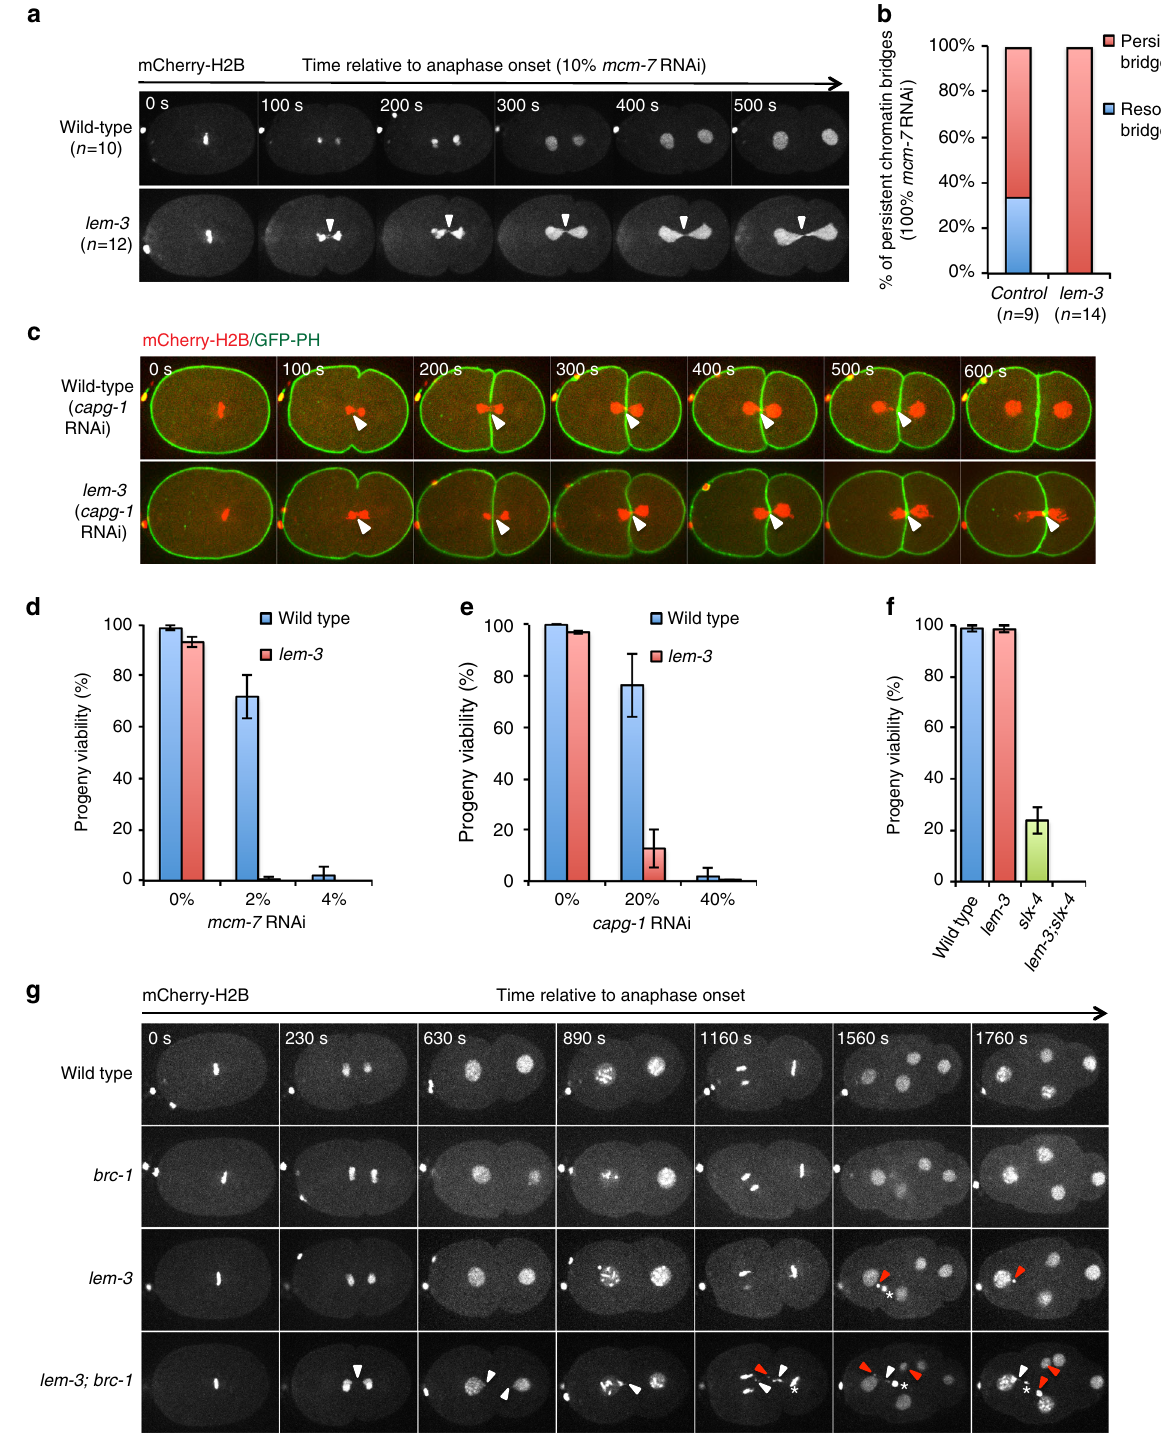
Fig. 3 LEM-3 contributes to chromatin-bridge resolution. a Chromosome segregation in wild type and lem-3 mutant embryos upon partial depletion of DNA replication helicase subunit MCM-7. Images were taken from embryos expressing mCherry-H2B fed on 10% mcm-7 RNAi producing bacteria. Arrowheads indicate chromatin bridges. Times are relative to anaphase onset of the fi rst division. b Quanti fi cation of chromatin bridges that persist into the next cell division in wild type and lem-3 mutant embryos upon full depletion of MCM-7 (100% mcm-7 RNAi). n sample size. c Persistent capg-1 RNAi induced chromatin bridges in lem-3 mutants. Chromosome segregation in wild type and lem-3 mutant embryos upon depletion of condensin I subunit CAPG-1 (100% capg-1 RNAi). Images were taken from control and capg-1 RNAi embryos expressing mCherry-H2B and GFP-PH. d , e Progeny viability of lem-3 mutants upon partial depletion of MCM-7 ( d ) and CAPG-1 ( e ). f Genetic interaction between LEM-3 and SLX-4. Error bars represent standard deviation of the mean. g LEM-3 and BRC-1 are required for faithful chromosome segregation after IR. White arrowheads indicate chromosome bridges, red arrowheads indicate micronuclei. Stars indicate polar